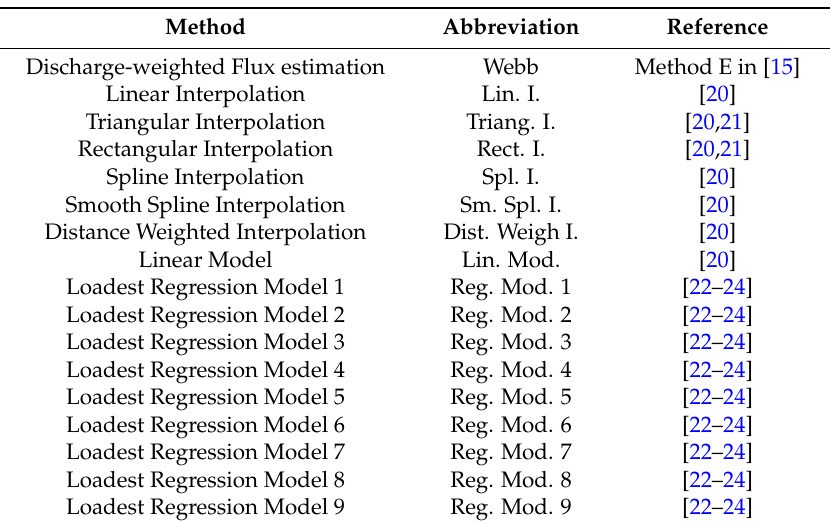
Table 1. Overview of the applied flux calculation methods. For the detailed calculation procedures, refer to the indicated